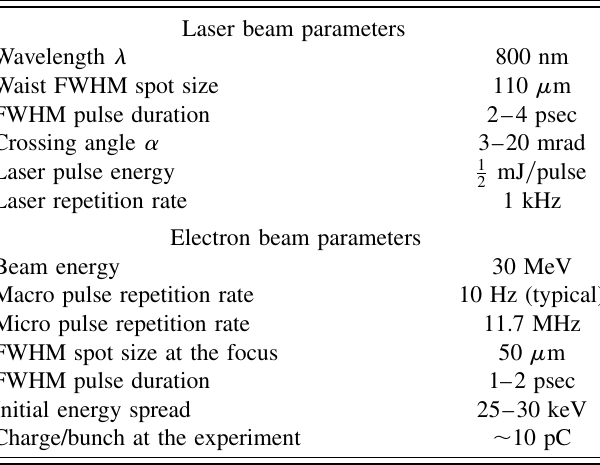
TABLE I. Laser and electron beam parameters of the LEAP